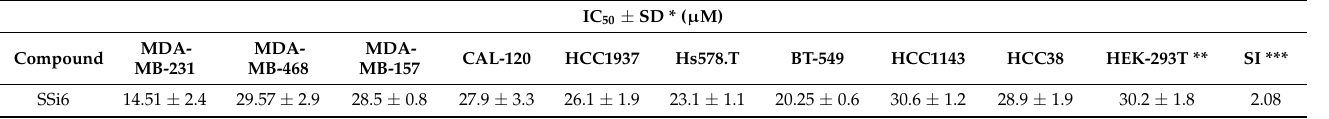
Table 1. IC 50 values of SSi6 in human triple-negative breast cancer cell lines after 72 h of